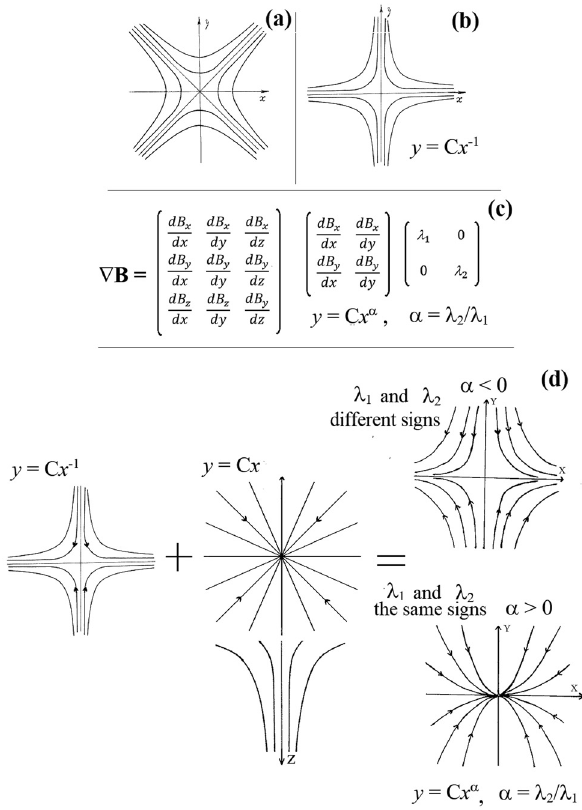
Figure 2: Superposition of X - type magnetic fi eld and diverging magnetic fi eld. ( a ) plane X - type con fi guration in usual coordinate system and ( b ) in the coordinate system rotated by 45°, in which it is convenient to consider the superposition of magnetic fi elds. ( c ) matrix ∇ B , its representation in chosen coordinate system through eigenvalues, expression for magnetic lines of super - imposed fi elds. ( d ) illustration of fi elds superposition